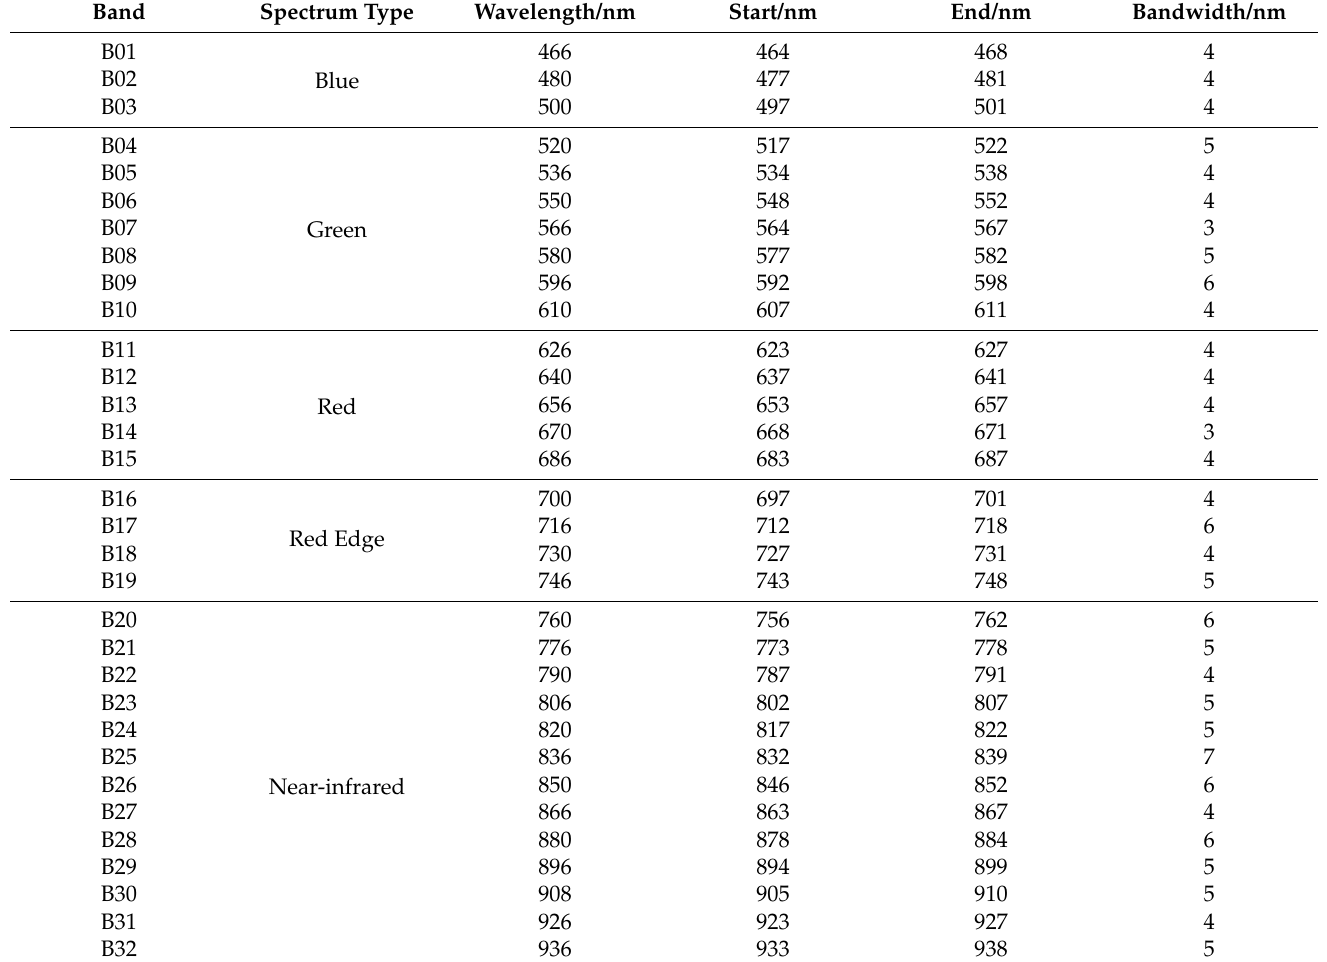
Table 1. ZH-1 hyperspectral satellite data band